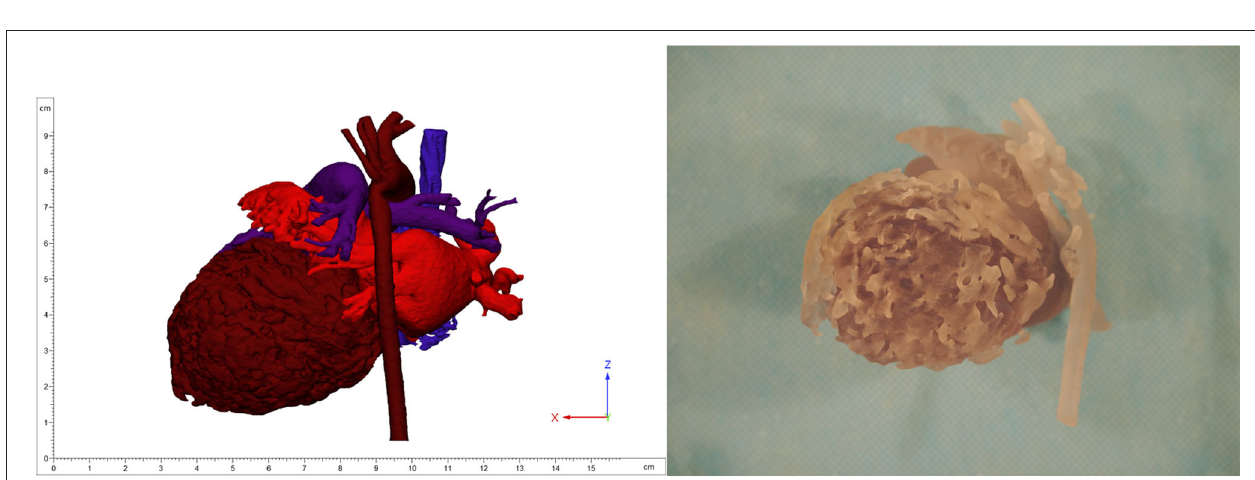
FIGURE 1 | Non-compacted myocardium measures 11.9–12.9mm, and the compacted myocardium measures 3.7–4.2mm in the sagittal plane.